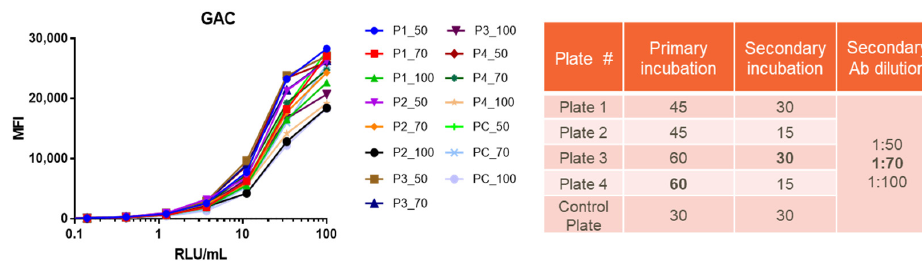
Methods Protoc. 2022 , 5 , x FOR PEER REVIEW 13 of 14 Figure A2. Standard curve optimisation (GAC only shown) with Privigen IVIG serially diluted 3-fold from 1:1000 dilution (nominal concentration 100 RLU/mL) to 1: 1:6,561,000.